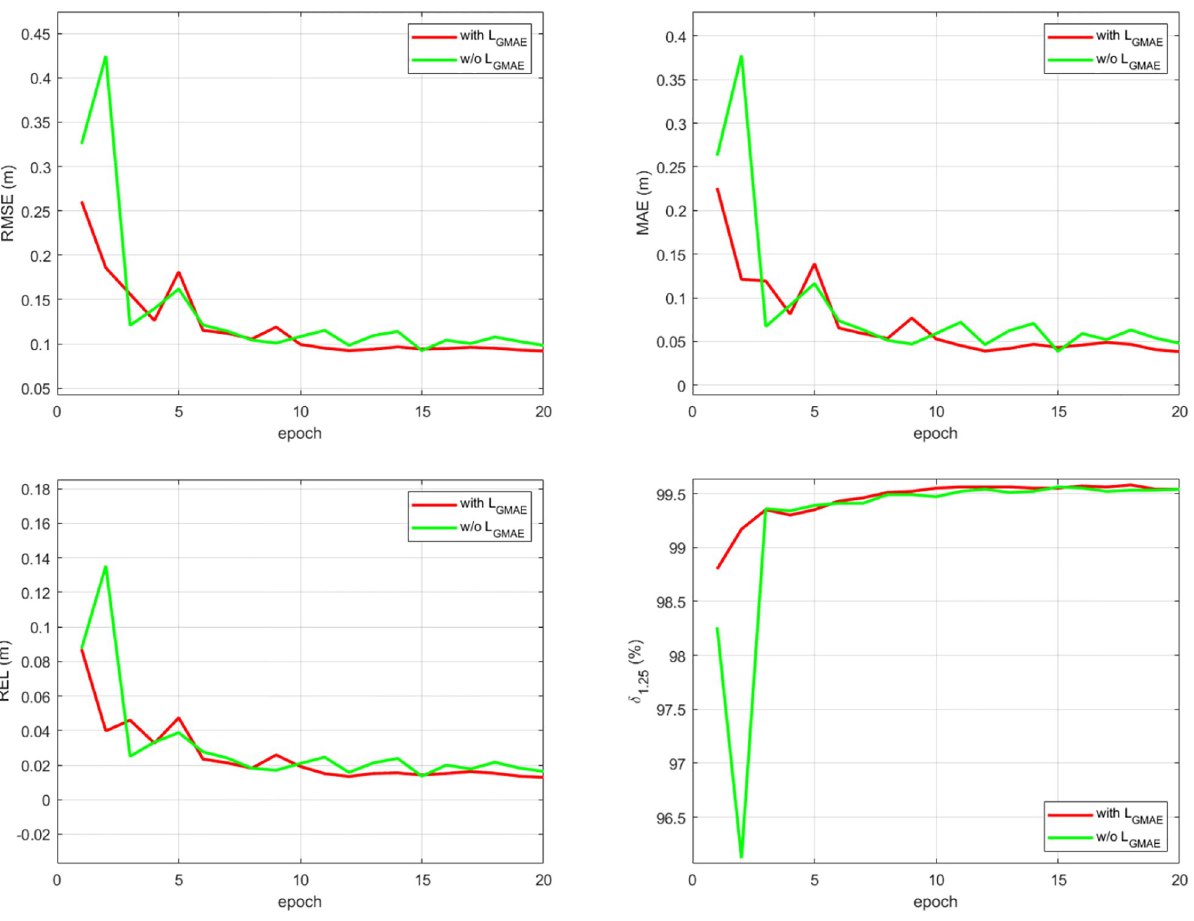
Fig 9. Convergence comparison between with and w/o L GMAE